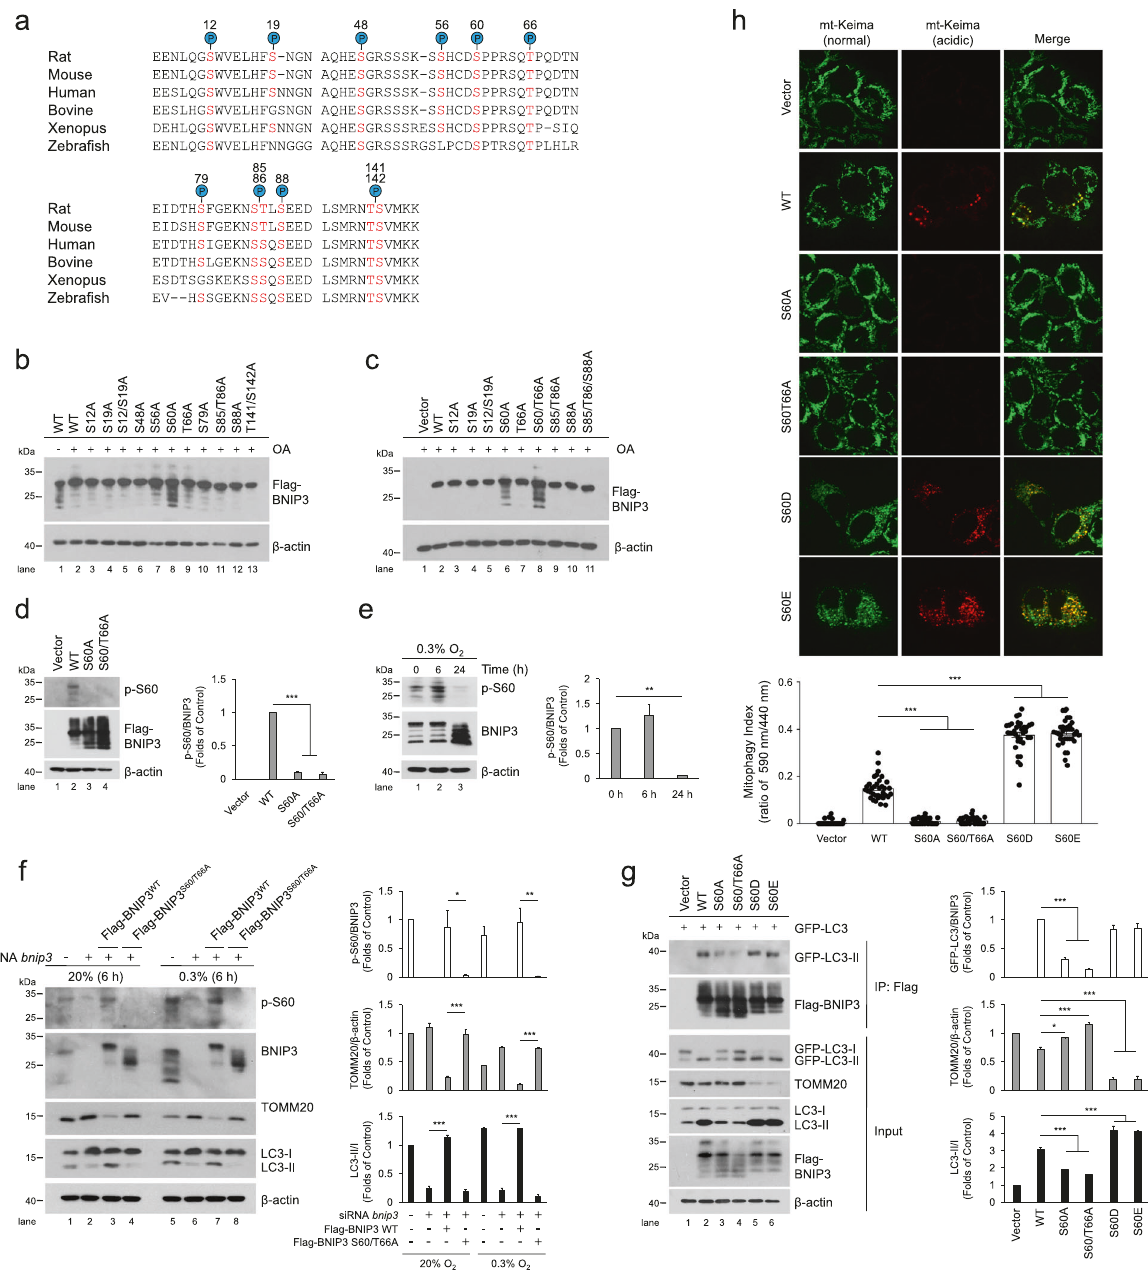
Fig. 2 Phosphorylation of BNIP3 at S60/T66 is critical to promote mitophagy by enhancing its interaction with LC3. a Putative BNIP3 phosphorylation sites based on reported proteomics data (PhosphoSitePlus ® ) that are conserved across different species. Conserved serine and threonine residues are marked in red. b , c HeLa cells were transfected with empty vector and Flag-BNIP3 plasmids encoding either wild- type (WT) or mutant BNIP3 constructs generated via site-directed mutagenesis. After 48 h of transfection, cell lysates were detected via western blotting with anti-Flag antibody. OA, okadaic acid. d HeLa cells were transfected with empty vector, WT, S60A or S60/T66A mutant Flag-BNIP3 plasmids, phosphorylation of BNIP3 was detected via western blotting using a phospho-speci fi c antibody against BNIP3 at Ser 60 (p-S60). n = 3. e The phosphorylation level of BNIP3 at Ser 60 in PC12 cells was measured under 0.3% O 2 for the indicated time. n = 3. f PC12 cells were treated with Bnip3 siRNA and transfected with Bnip3 siRNA-resistant WT or S60/T66A plasmids, and then cells were exposed to 20% O 2 or 0.3% O 2 for 6 h, respectively. Mitophagy and the phosphorylation of BNIP3 were detected via western blotting. n = 3. g HeLa cells were transfected with GFP-LC3 and empty vector, WT or the indicated Flag-BNIP3 mutants for 48 h. Cell lysates were immunoprecipitated with anti- Flag antibody and then subjected to western blot analysis with the indicated protein antibodies. n = 3. h The indicated plasmids were transfected into HeLa cells stably expressing mt-Keima and cell images were captured with a confocal microscope. Mitophagy was identi fi ed and quanti fi ed by the ratio of acidic (590 nm, red) to normal mitochondria (440 nm, green). Scale bar, 10 μ m. n = 35. The data are expressed as means ± SEM. * P < 0.05, ** P < 0.01, *** P < 0.001 versus the indicated group.